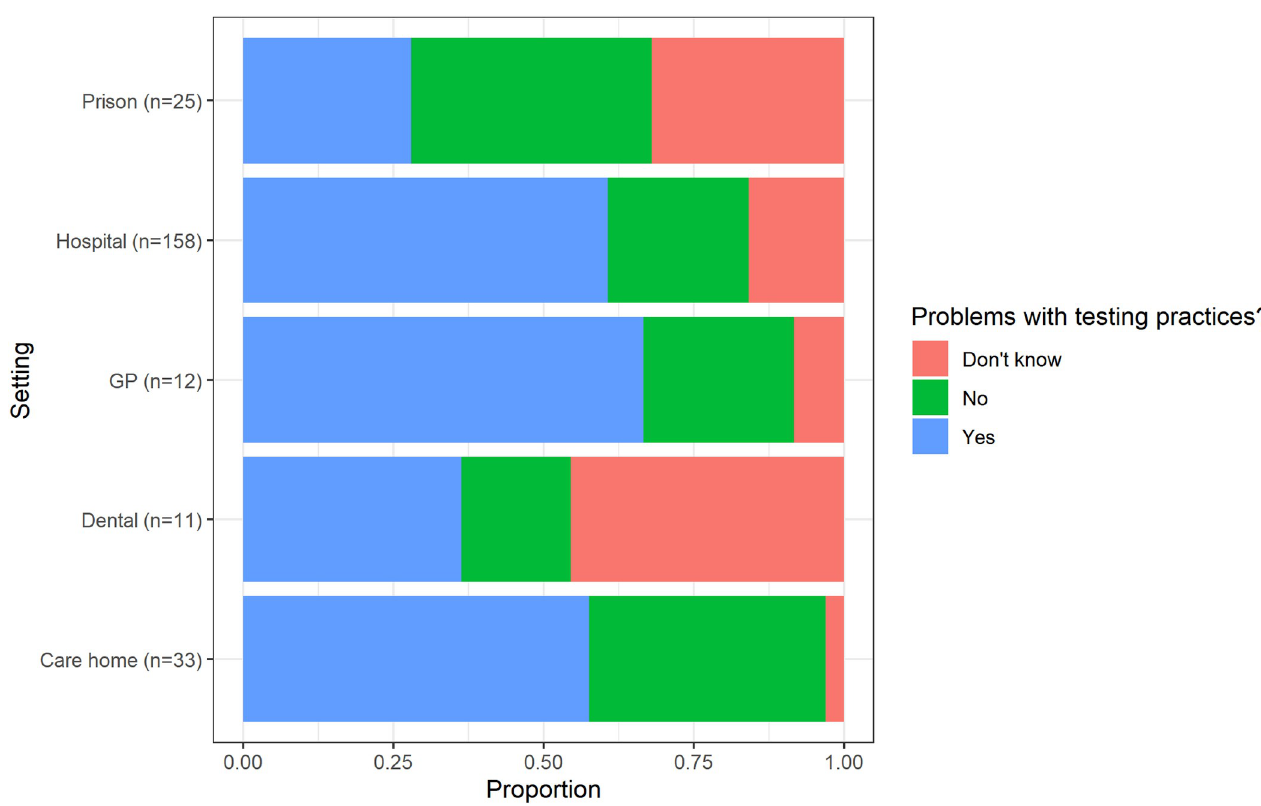
Fig 4. Perception of problems associated with COVID-19 testing practices in each setting. Primary and secondary dental settings were merged, in addition to care homes with and without nursing. The ‘Hospital-at-home’, hospice and ambulance setting were excluded due to the small number of overall respondents (n < 15). Respondents selected a single ’Yes’, ’No’ or ’Don’t know’ answer. The number of responses from individual settings for this particular question is displayed on the y axis (n =